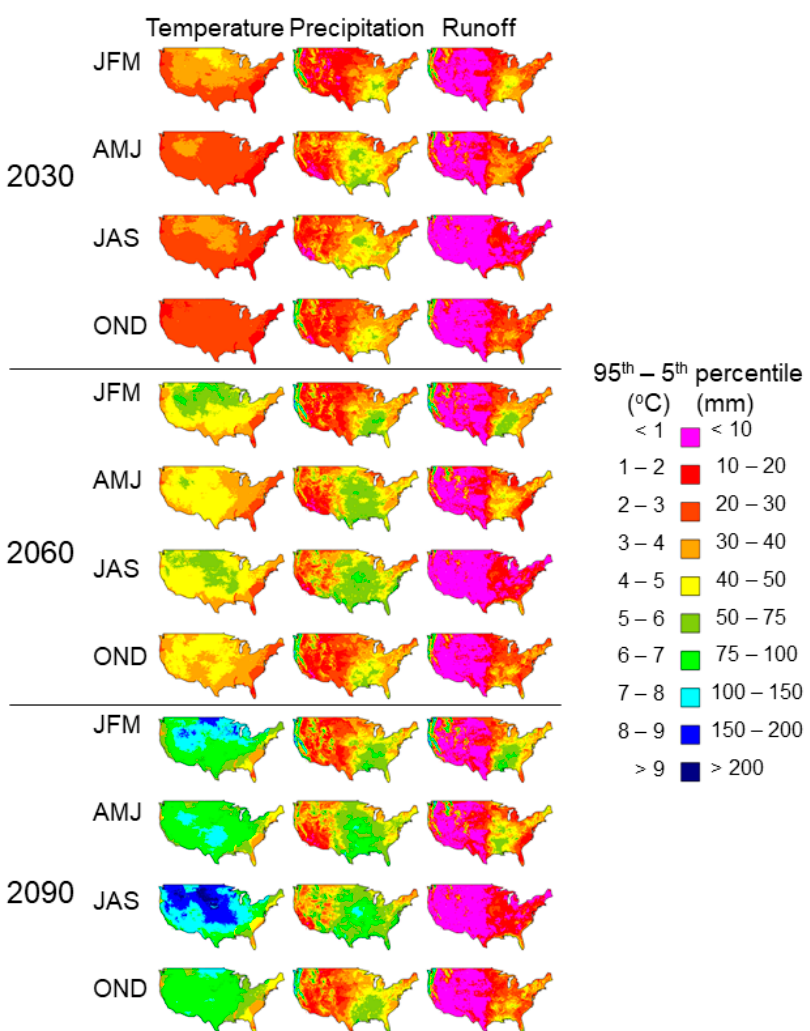
Figure 6. Range (95th percentile − 5th percentile) of departures in seasonal average monthly temperature in degrees Celsius ( ◦ C), and precipitation and runo ff in millimeters (mm) projected for 2030, 2060, and 2090 from 214 climate simulations. JFM, January–March; AMJ, April–June; JAS, July–September; OND,